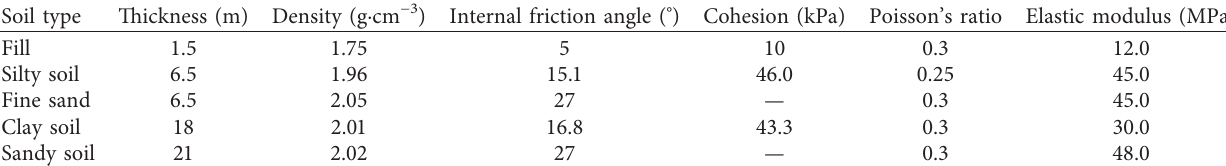
Table 1: Physical and mechanical properties of soils.